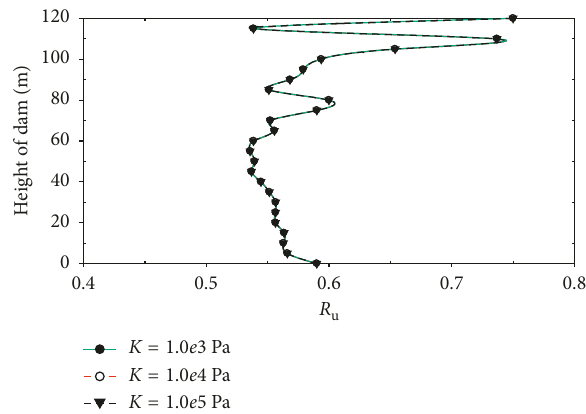
Figure 12: Comparing R u for different bulk modulus of water in the water-flow